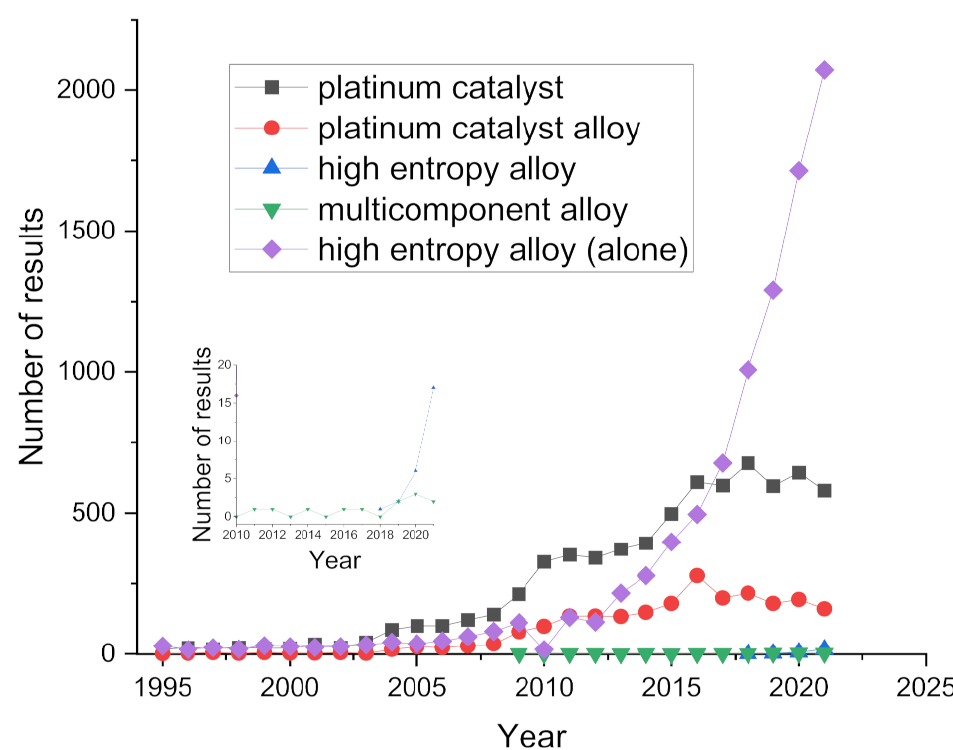
Figure 2. Time evolution of the overall number of papers that appear on Scopus using keywords “oxygen reduction reaction together with “platinum catalyst”, “platinum catalyst alloy”, “high- entropy alloy”, or “multicomponent alloy”, as well as “high-entropy alloy” alone. The inset shows the details for last years for HEA and multicomponent